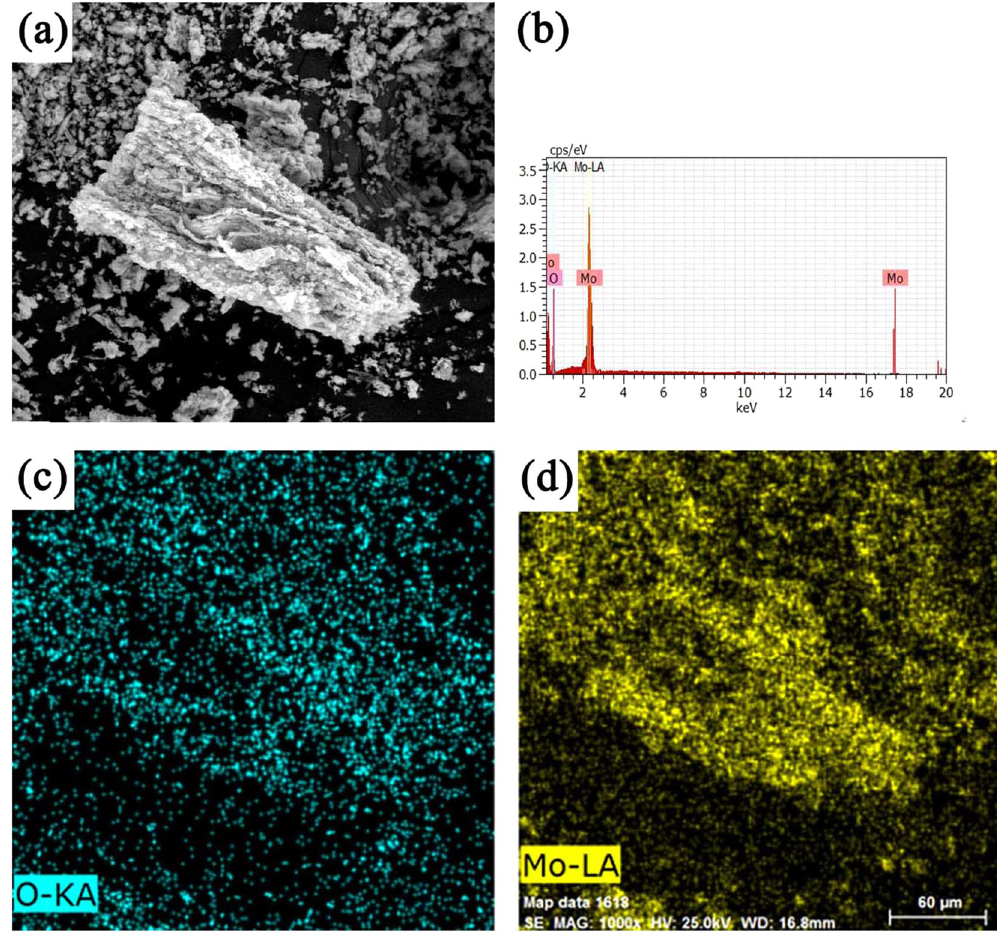
Figure 3. ( a ) SEM of the MoO 3 synthesized at 400 °C, ( b ) EDS spectrum, ( c,d ) Elemental mapping of Mo and